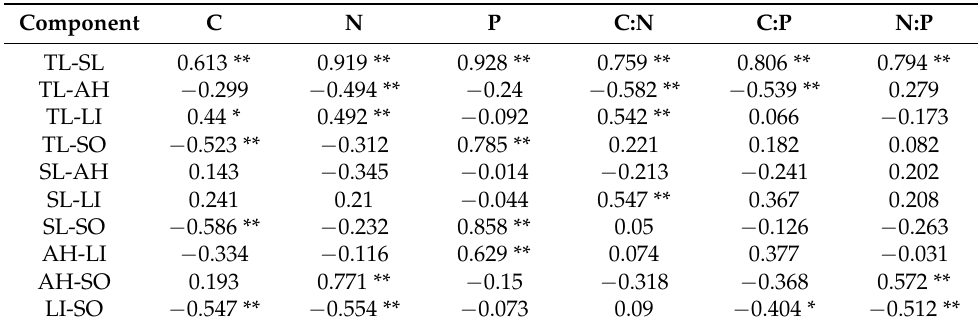
Table 2. Relationships between the C, N, and P contents of the different plant tissues ( n = 27). Plants Components C N P Leaves– 0.404 * − 0.847 ** − 0.587 ** Tree Branches Leaves-Stems 0.532 ** − 0.613 ** − 0.183 Leaves-Roots − 0.352 − 0.597 ** − 0.189 Branches-Stems − 0.298 0.724 ** 0.602 ** Branches-Roots − 0.142 0.557 ** 0.458 * Stems-Roots 0.030 0.085 0.421 * Shrub Leaves-Branch 0.893 ** − 0.728 ** − 0.835 ** Leaves-Root 0.761 ** − 0.118 − 0.294 Branches-Roots 0.680 ** 0.142 0.439 * Herb Leaves-Roots − 0.103 0.684 ** 0.717 **